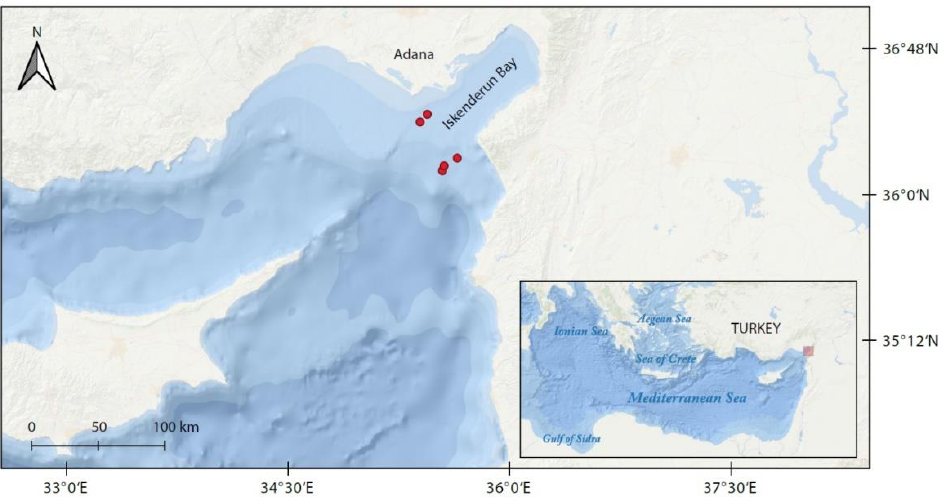
Figure 1. Red dots indicate out of Iskenderun Bay, Turkey, where Dipturus oxyrinchus specimens were collected.